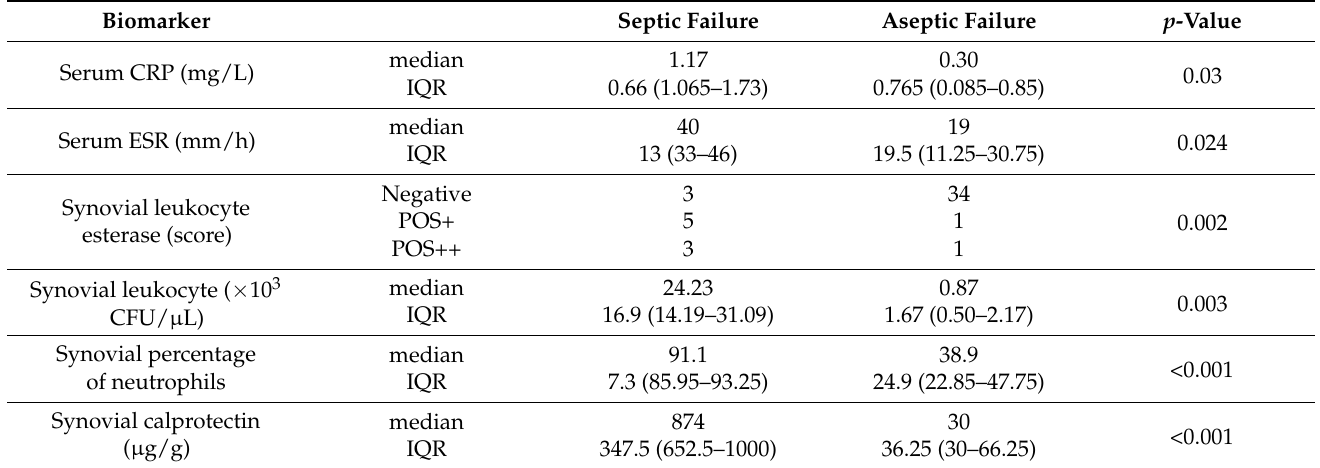
Table 2. Median and IQR values of the serum and synovial markers of PJI.